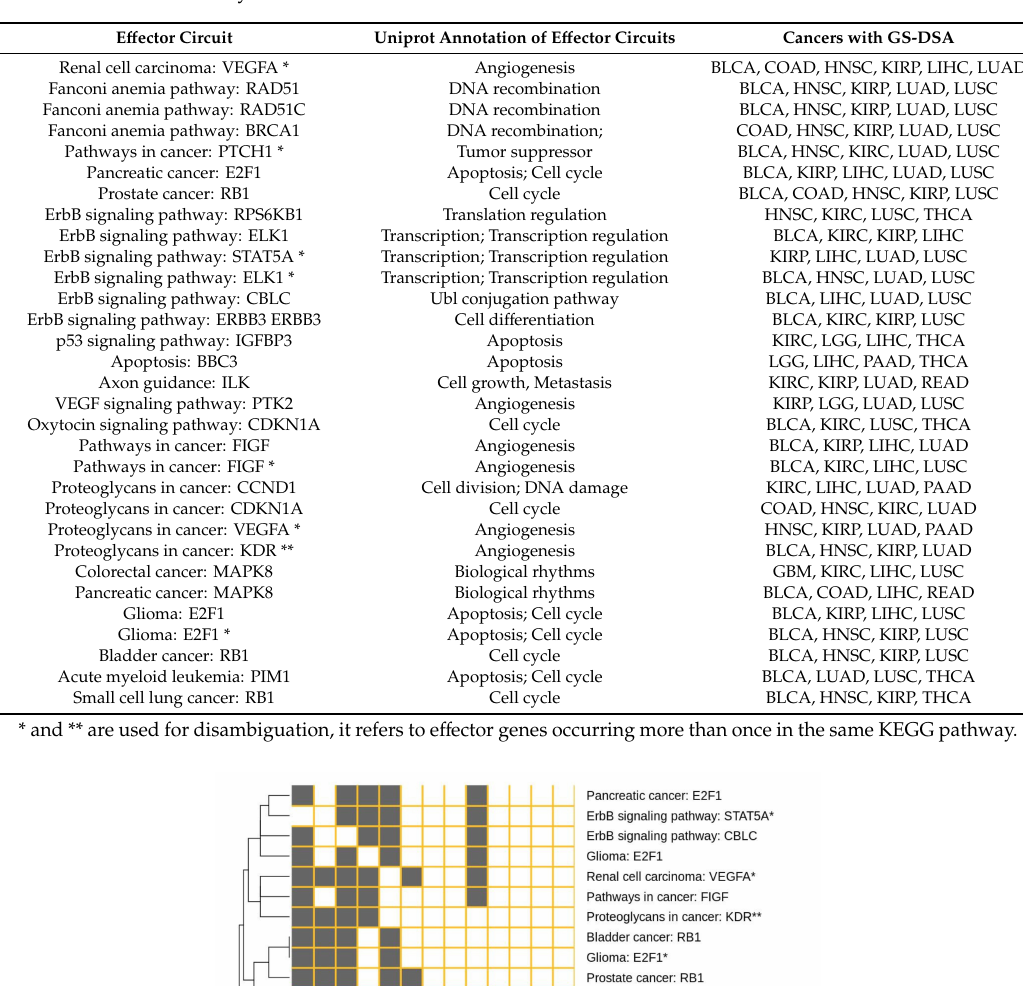
Table 3. Circuits showing gender-specific di ff erential signaling circuit activation in four or more cancers simultaneously.